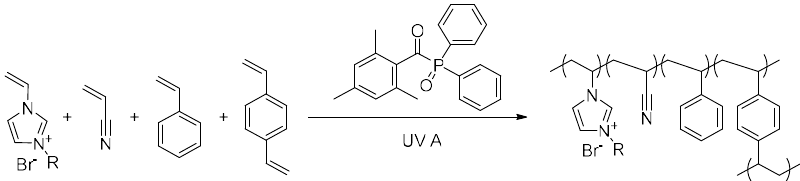
Figure 1. General polymerization reaction using diphenyl(2,4,6-trimethylbenzoyl)phosphine (TPO) as a UV photo initiator.